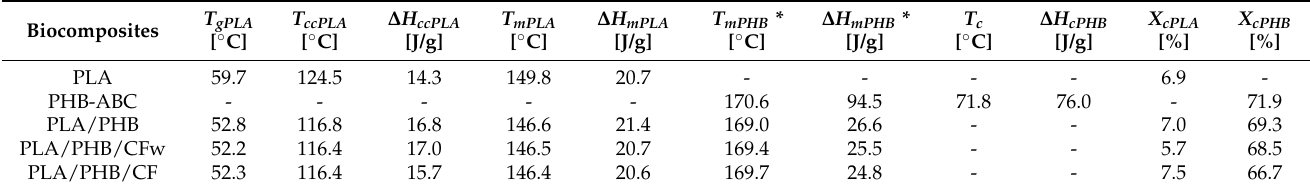
Figure 3. ( a ) DSC thermograms-heating cycle and ( b ) DSC thermograms-cooling cycle for the polymers, blend, and biocomposites. Table 3. DSC data for the PLA, PHB, PLA/PHB blend, and